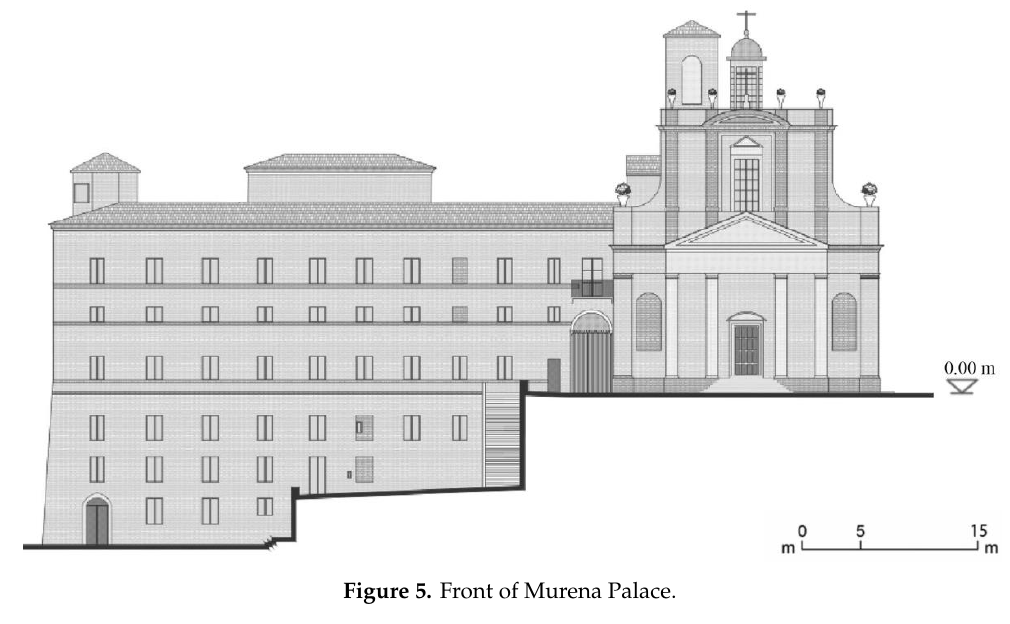
Figure 5. Front of Murena Palace.